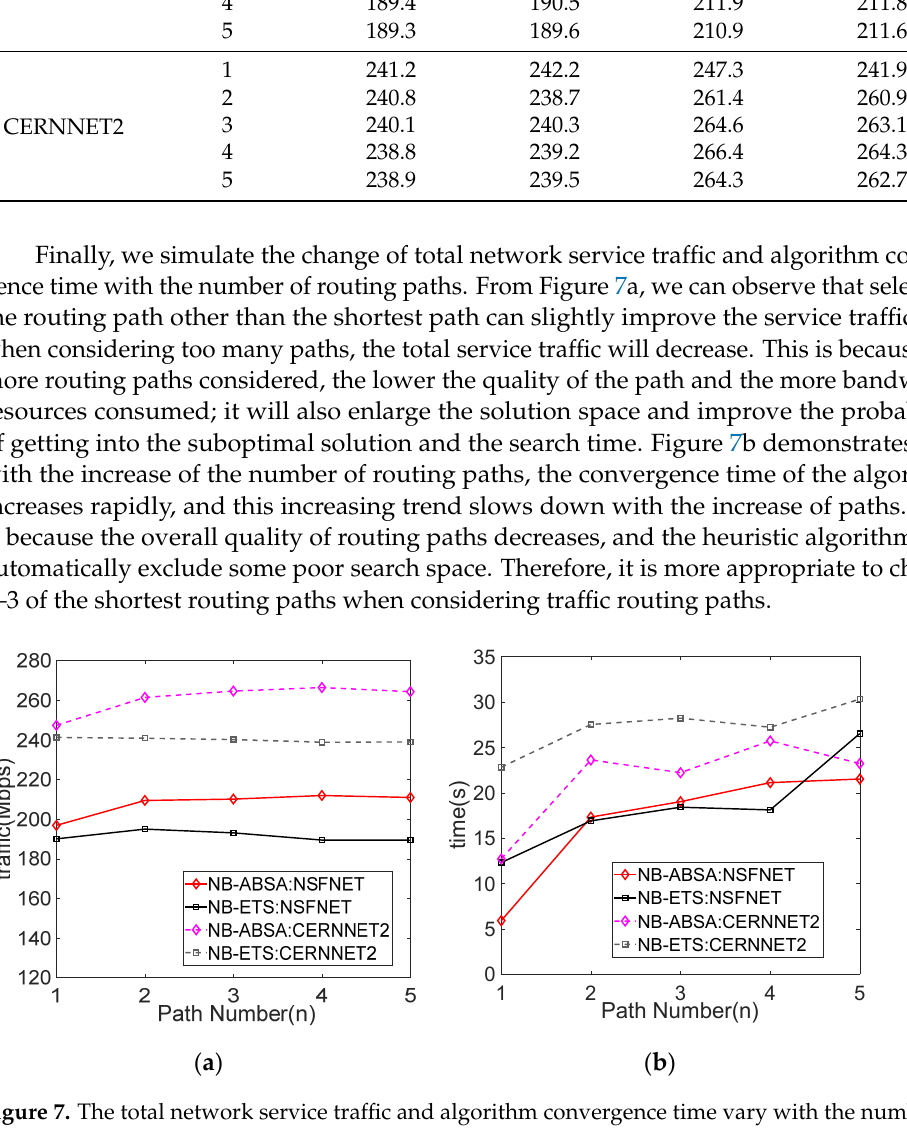
Table 2. Network service traffic of heuristic SFC deployment algorithm based on NBACO-SS.